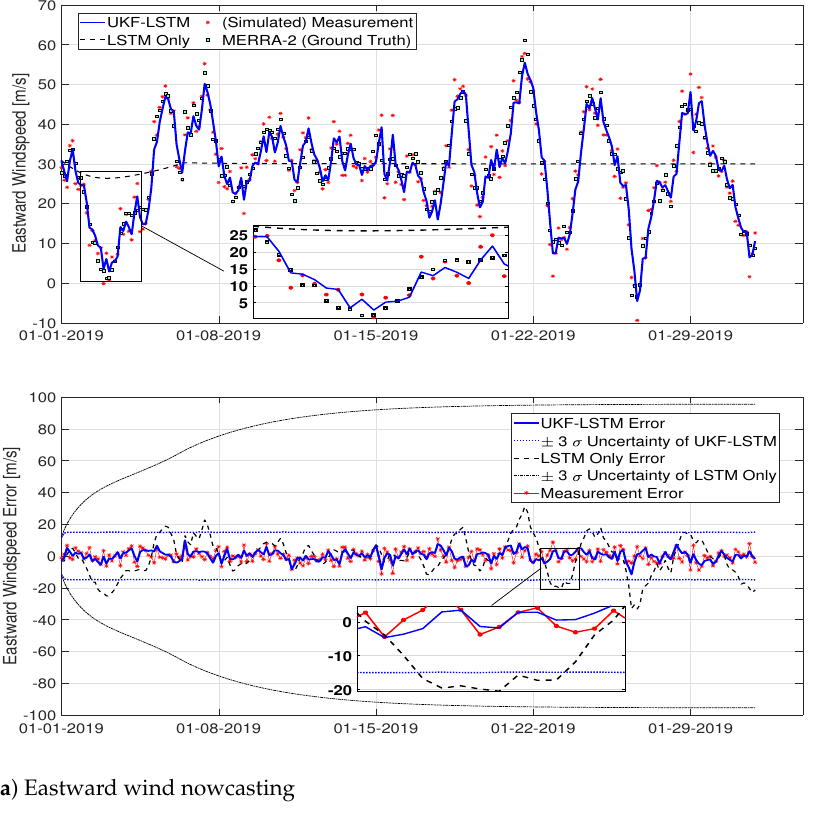
(Simulated) Measurement MERRA-2 (Ground Truth)